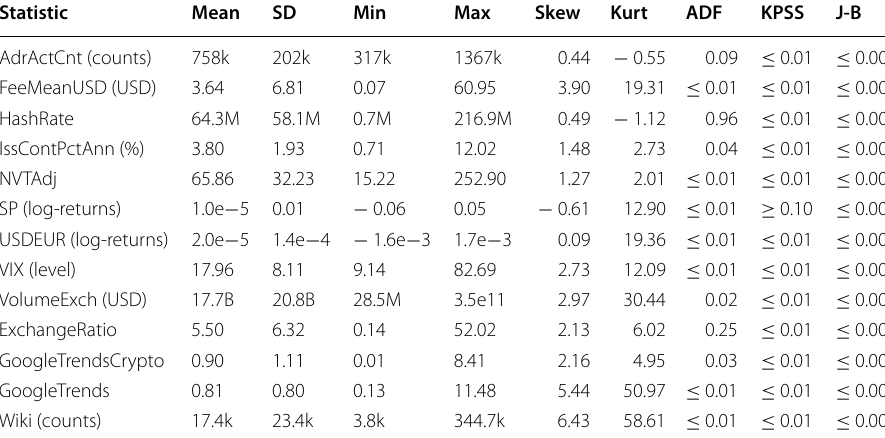
N = 2223 observations, p values reported for the statistical tests